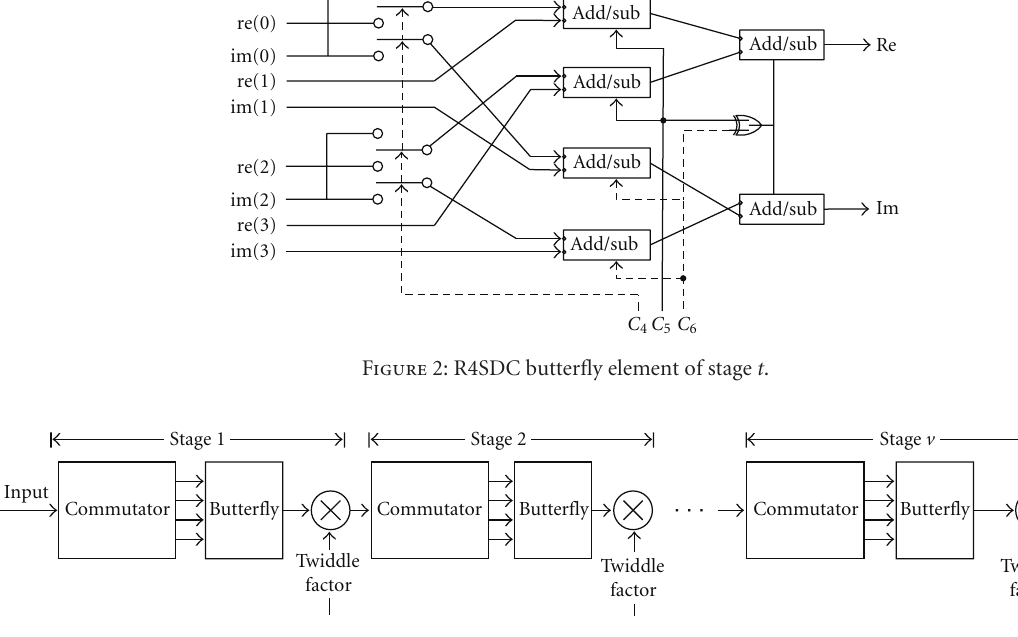
Figure 3: N -point R4SDC pipeline FFT processor